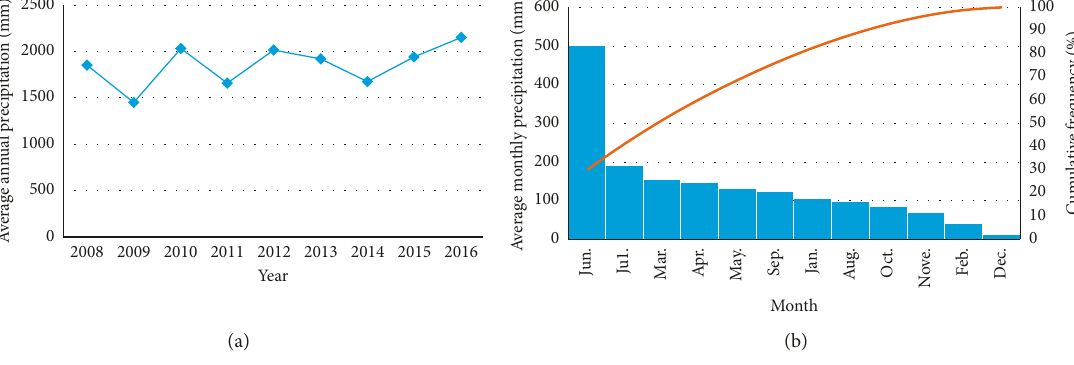
Figure 2: Multiyear average precipitation from 2008 to 2016 (a) and frequency distribution of average monthly precipitation (b) of 11 meteorological stations in